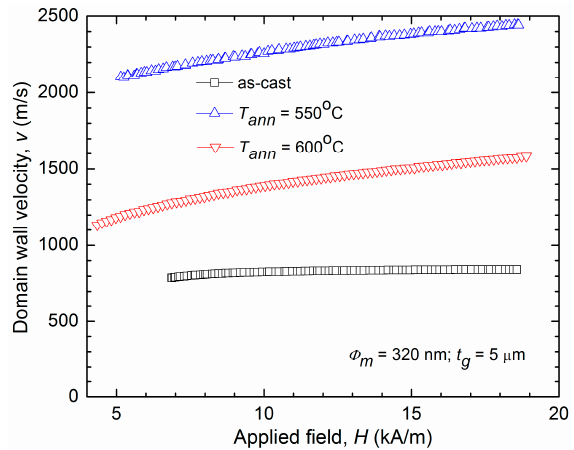
Figure 10. Dependence of the domain wall velocity on the applied magnetic field for a submicron Fe 73.5 Cu 1 Nb 3 Si 13.5 B 9 sample with Φ m = 320 nm in as-cast state and after annealing for 60 min at 550 °C and 600 °C, respectively.